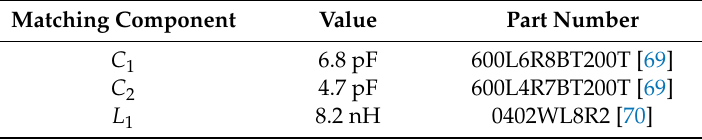
Table 4. Summary of the used matching network components.